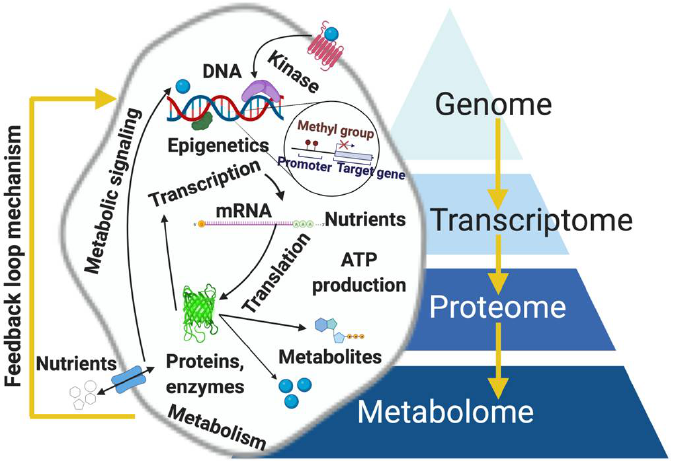
Figure 2. Hierarchical dimension of the omics reflecting metabolome in the most downstream position, directly linking genotype to the phenotype of a diseased cell. Results of metabolomics serve as inputs for further genomic analysis (i.e., feedback loop mechanism). Figure drawn using BioRender [26].